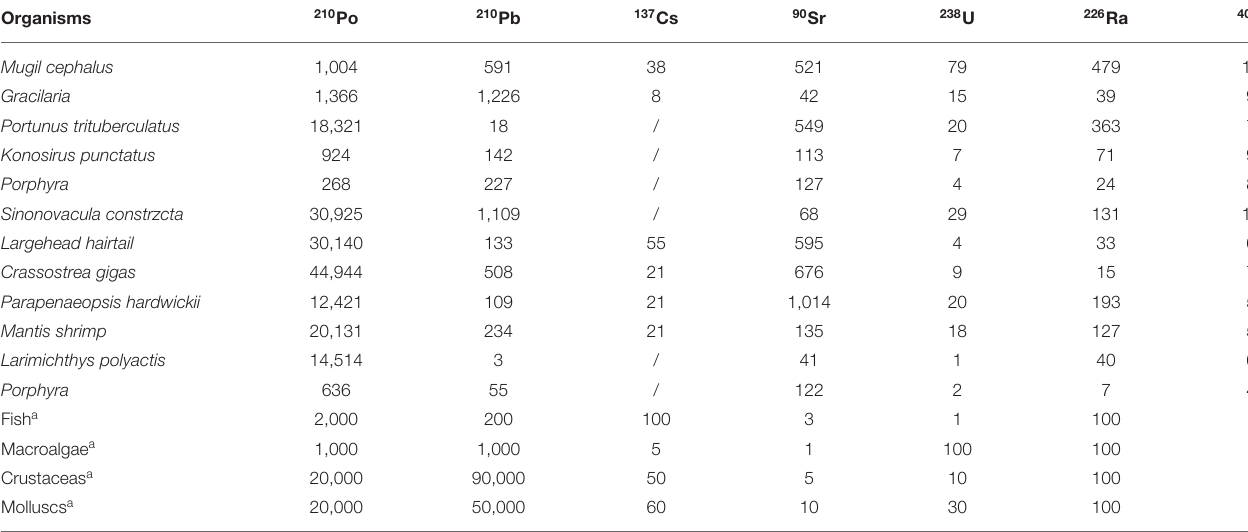
TABLE 4 | Bioconcentration factors of 210 Po and 210 Pb and other radionuclides in marine organisms sampled in this study. Organisms